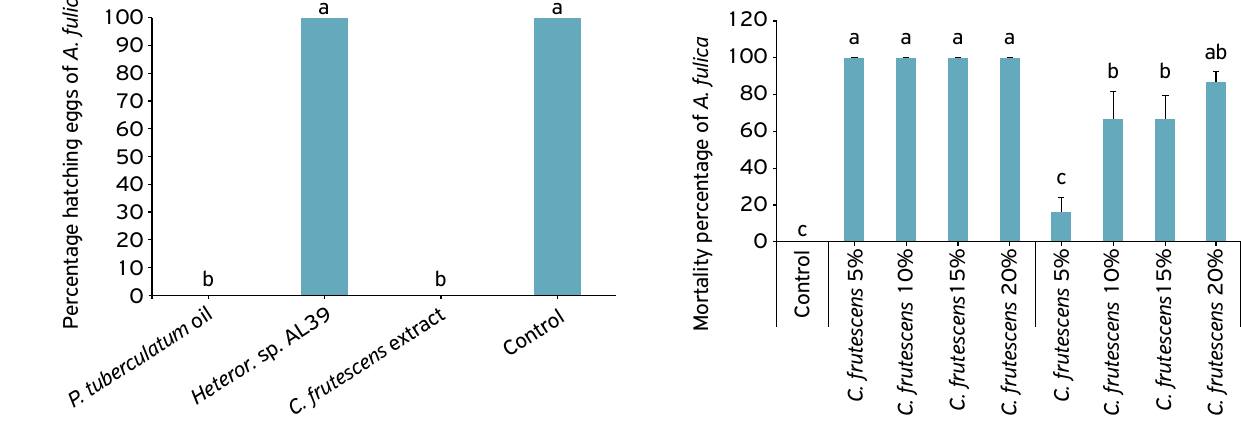
Figure 2. Percentage ( ± standard error) hatching eggs of Achatina fulica treated with Heterorhabditis sp. AL39, alcoholic extract and oil of Capsicum frutescens and Piper tuberculatum .